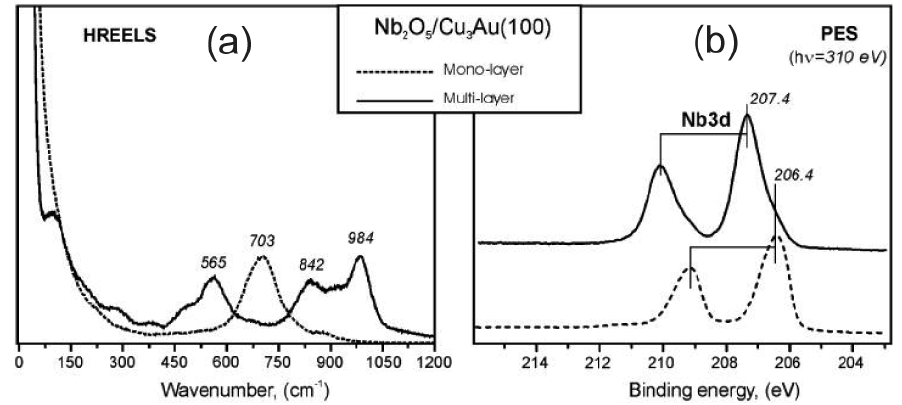
Fig. 8 – STM images of the niobia film grown on Cu 3 Au(100). (a) Large terraces separated by steps of ∼ 2Å in height. (b) Hexagonal structure of the niobia film with vacancy defects. The ( 2 × 7 ) superstructure cell is marked as a rectangle. (c) Two domains rotated by 90 ◦ , with each domain exhibiting characteristic surface modulation seen as stripes. Image sizes and tunneling parameters are: (a) 200 × 200 nm 2 , VS = 1 . 4 V, I = 1 . 0 nA; (b) 15 × 15 nm 2 , VS = 1 . 4 V, I = 1 . 0 nA; (c) 40 × 40 nm 2 , VS = 1 . 4 V, I = 1 . 0 nA. 2(d) Cross and top views of the thin niobia film grown on Cu 3 Au(100). The unit cell of niobia overlayer is indicated as a rhomb. The rectangle shows the ( 2 × 7 ) coincidence superstructure, which is formed between oxide and metal substrate lattices. The surface shows a hexagonal lattice with a 5.3Å periodicity (Mendes et al. 2006b, Starr et al. 2005).